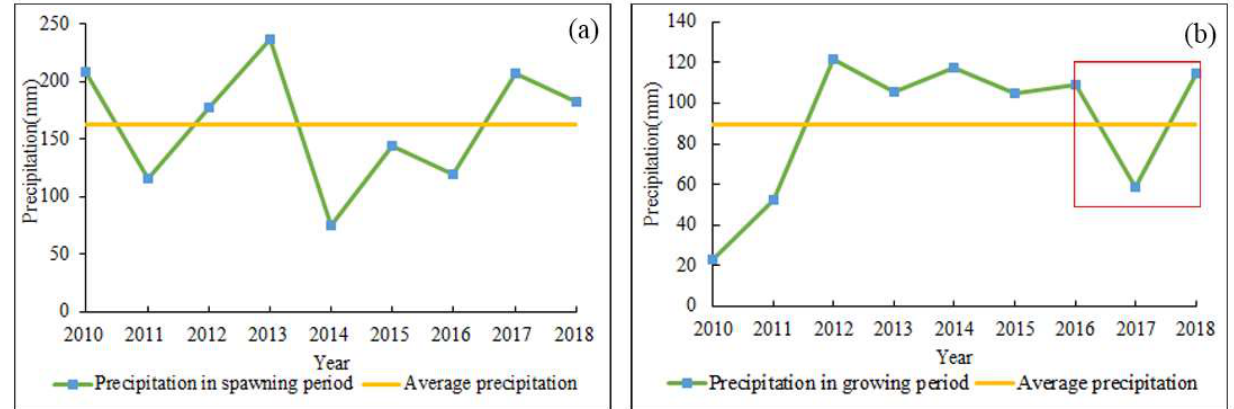
Figure 8. ( a ) Spawning period (August) precipitation from 2000 to 2018; ( b ) growing period (June) precipitation from 2010 to 2018.